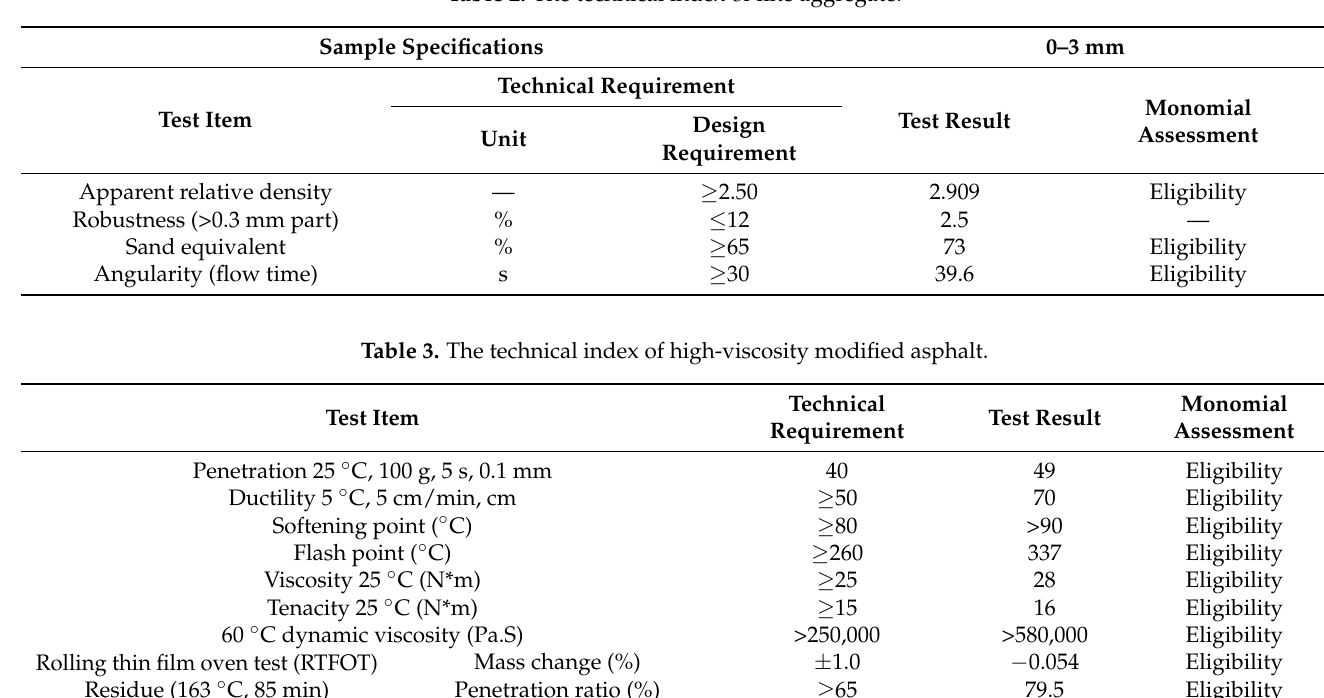
Table 2. The technical index of fine aggregate.